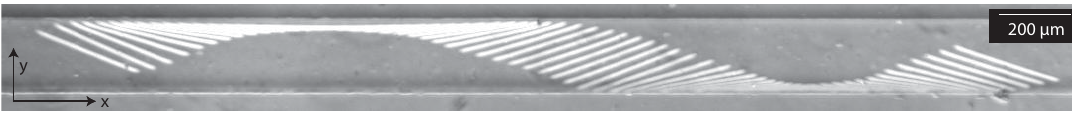
Figure 11. Time-lapse image of a fiber flowing in the channel. Two hundred milliseconds separate two successive positions. The channel width is 200 µ m; fiber length 290 µ m. The corresponding video is available in Supplementary Materials Video S4.